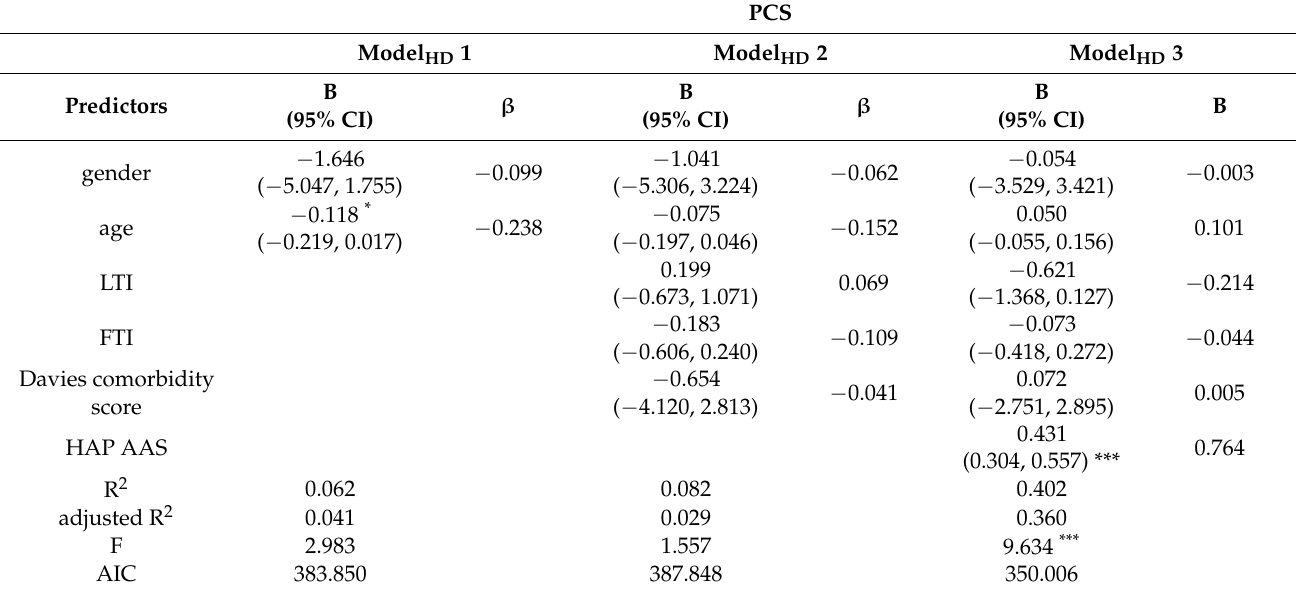
Table 4. Hierarchical multiple linear regression models of PCS ( n = 93).